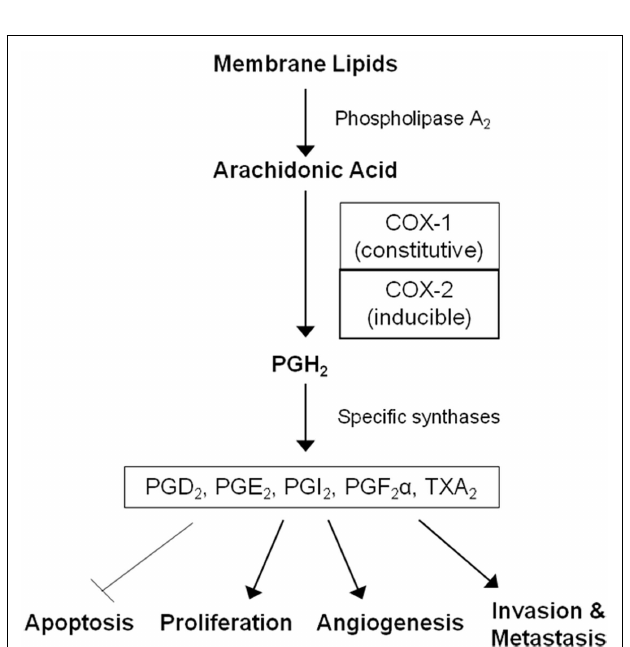
FIGURE 2 |The arachidonic acid cascade and cancer development . COX enzymes catalyze the conversion of arachidonic acid into prostaglandin H 2 , the precursor for all prostaglandins (PGs) and thromboxane A 2 (TXA 2 ). PGH 2 is further converted into PGD 2 , PGE 2 , PGI 2 , PGF 2 α , andTXA 2 by specific synthases.These molecules mediate inflammation and are also involved in gastrointestinal epithelium homeostasis, platelet activation, and kidney function. Prostaglandins can also promote cell proliferation, angiogenesis, metastasis, and inhibit apoptosis leading to tumor growth.